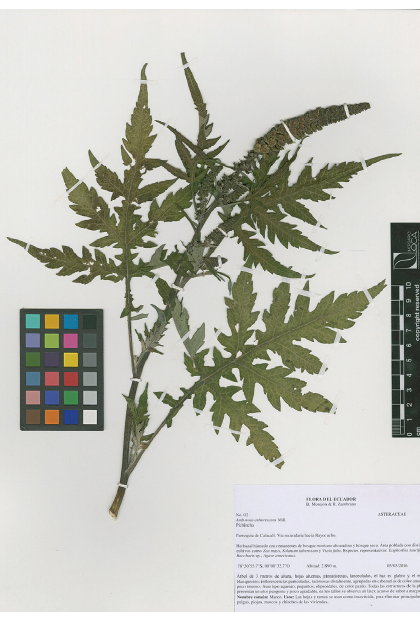
Figure 1: Ambrosia arborescens (Mill.)